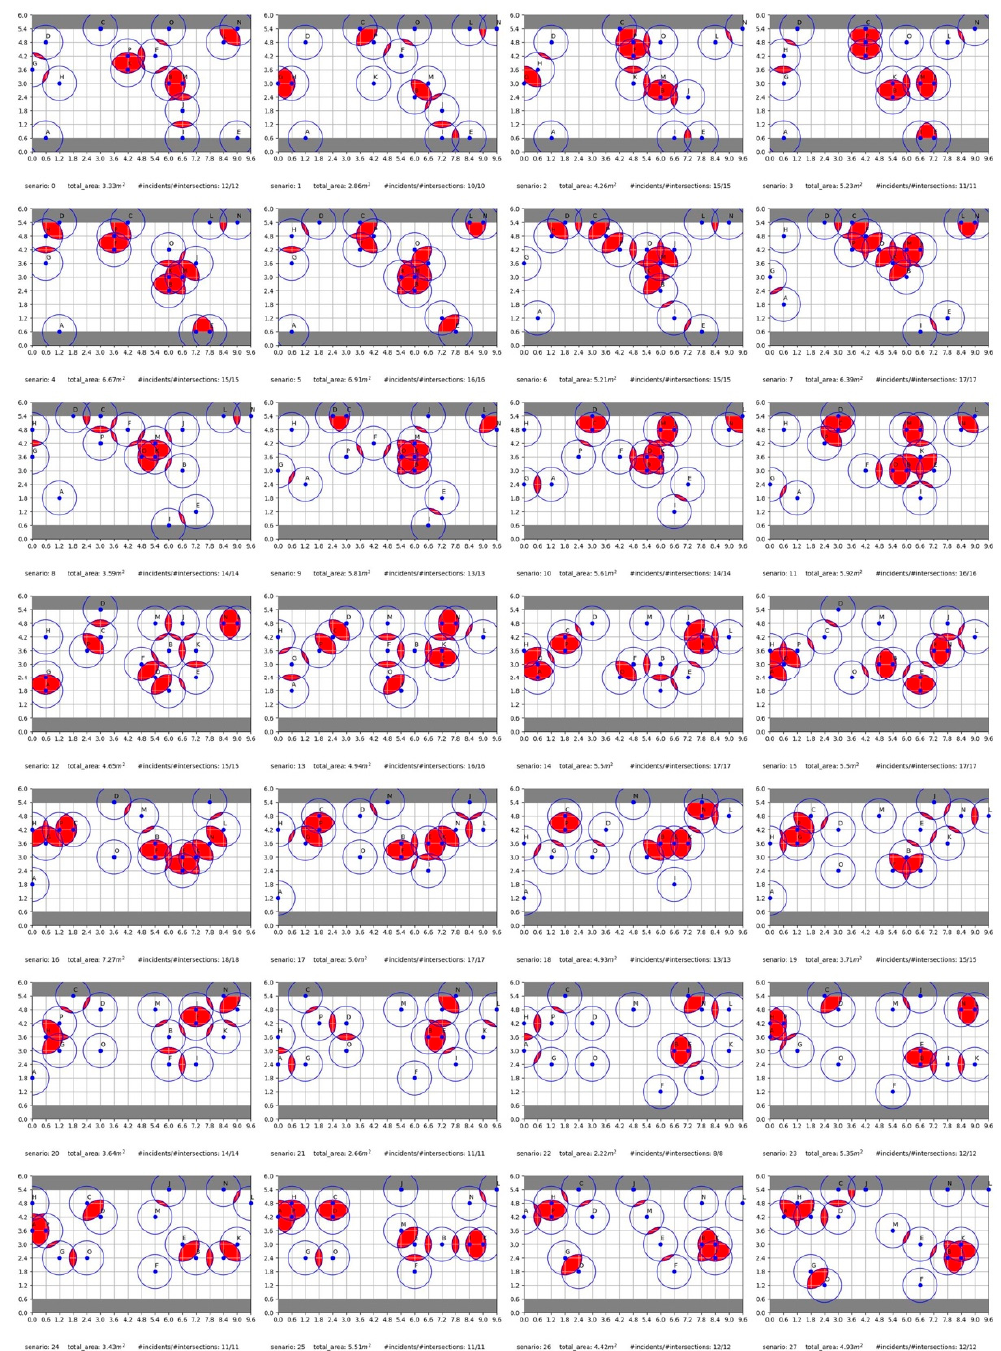
Figure 3. Graphic output showing simulated occupant positioning with the furniture layout for teaching and learning activity 1 (pinup), without contact time consideration.